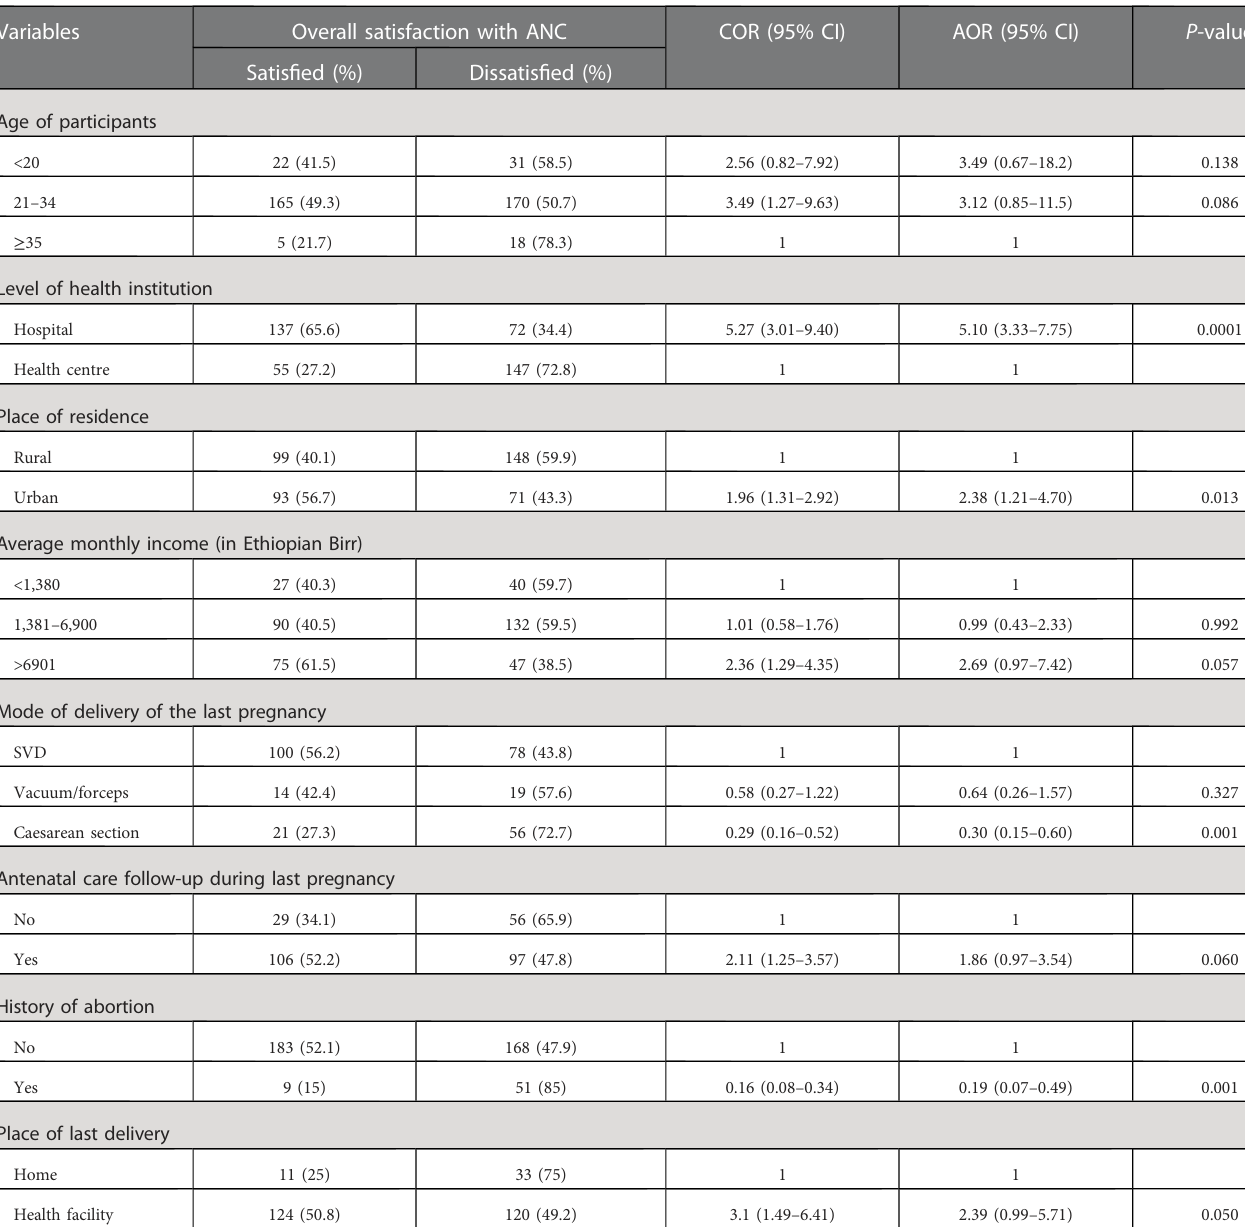
TABLE 4 Determinants of maternal satisfaction with ANC service among pregnant women receiving ANC at public health facilities in the West Shewa Zone, Central Ethiopia, 2021. Variables